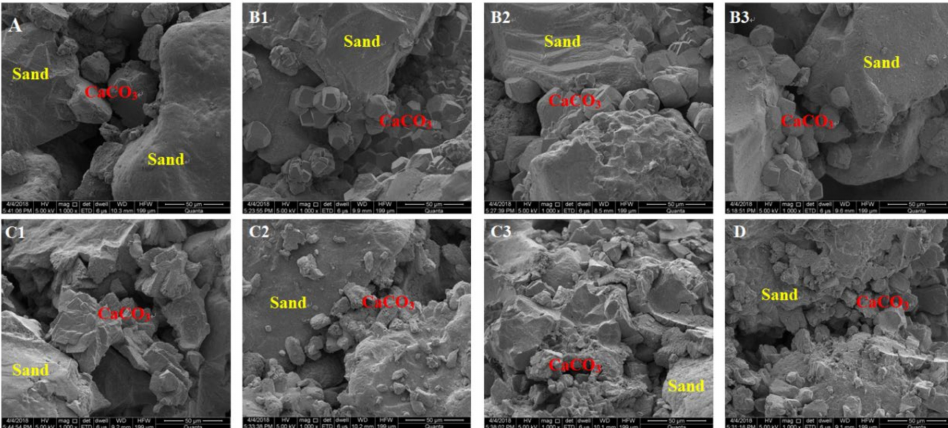
Figure 5. SEM image of sand solidified with various nutrient solution compositions. SEM image of group A ( A ); SEM image of group B1 ( B1 ); SEM image of group B2 ( B2 ); SEM image of group B3 ( B3 ); SEM image of group C1 ( C1 ); SEM image of group C2 ( C2 ); SEM image of group C3 ( C3 ); SEM image of group D ( D ).